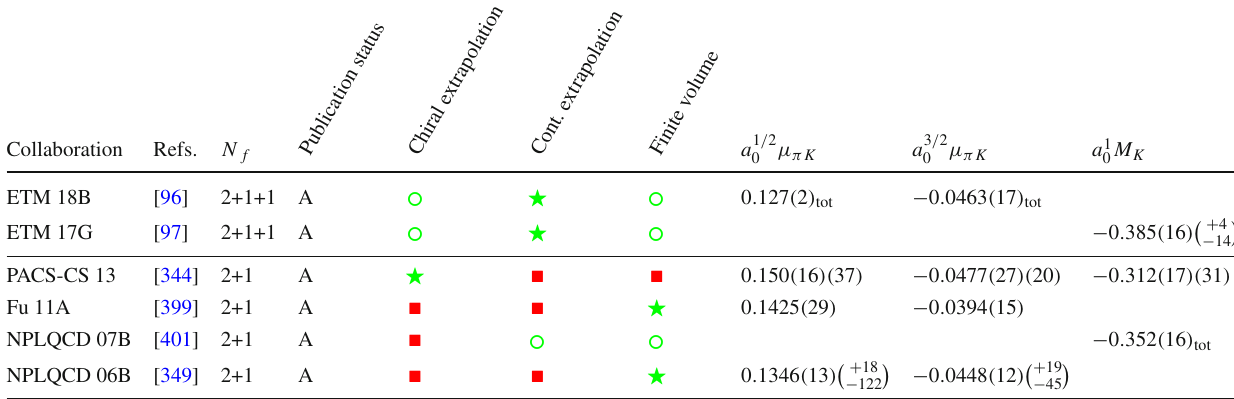
Table 27 Summary of π K scattering data in the I = 1 our sign